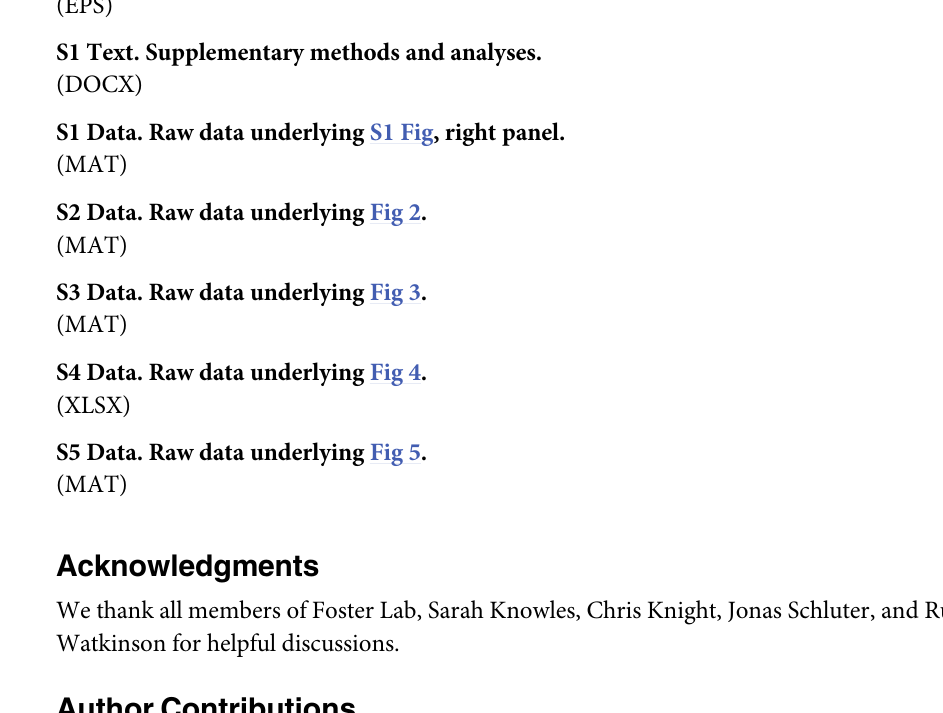
S5 Data. Raw data underlying Fig